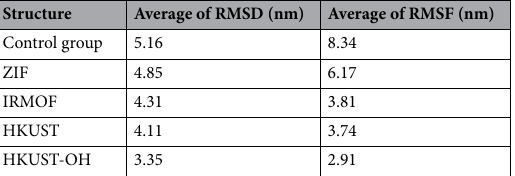
Table 1. The average amount of RMSD and RMSF for the control group and